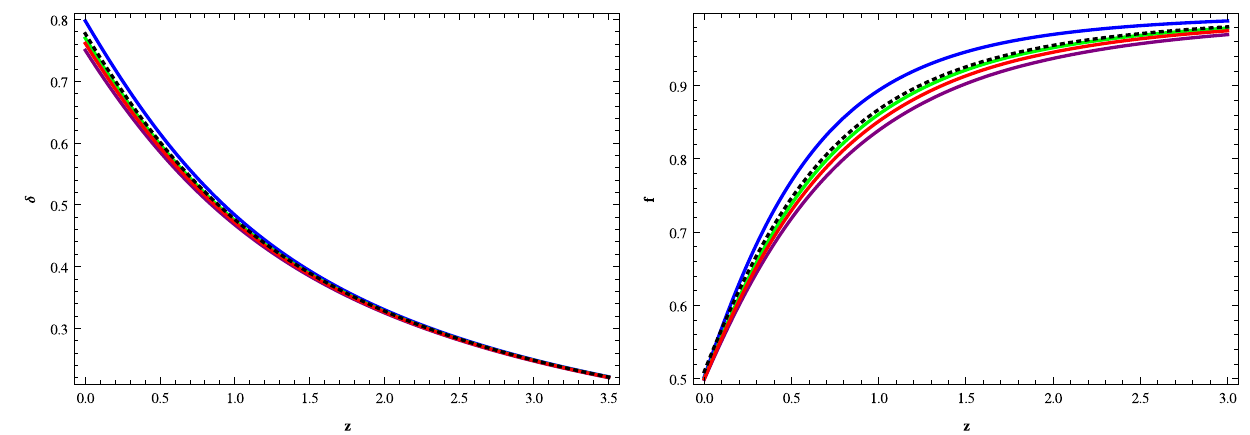
= − 1 . 041, and ω = − 0 . 95, respectively. In each plot, the black ω de de and red curves represent the corresponding evolutions of δ( z ) and f ( z ) in (cid:2) CDM ( ω de = − 1 ,η = 1) and GCG ( ω de = − 1) models, respec-